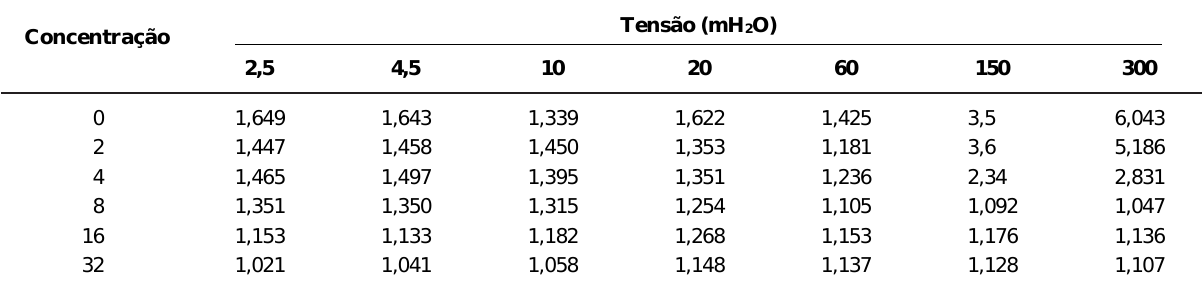
(b).Quadro Quadro 6. Razão adimensional dos parâmetros independentes: qqqqq e a Areia Quartzosa Figura 3. Perfis de umidade simulados pelo modelo numérico de Prevedello (1996) para o Latossolo (a) e Areia Quartzosa Marinha